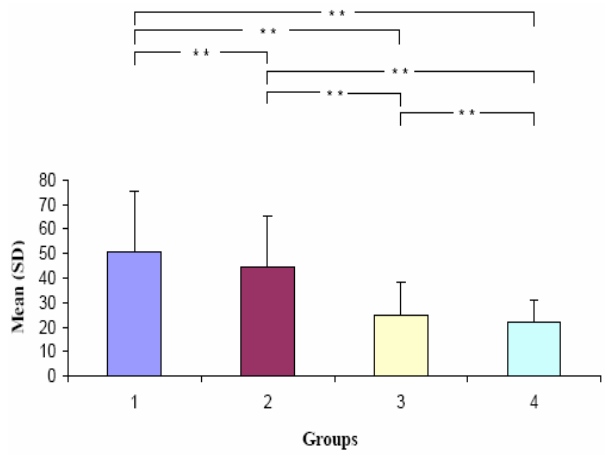
Figure 4 : Comparison between adherence indexes (mean ± DS). *, P<0.05; **, P<0.001. The completeness indicator per group is indicated by Figure 5. The median values range from 196.03 for group 1 to 176.59 for group 2 (group 1 versus group 2 where p <0.05); to 94.42 for group 3 (group 1 versus group 3 where p <0.001; group 2 versus group 3 where p < 0.001); to 90.25 for group 4 (group 1 versus group 4 where p <0.001; group 2 versus group 4 where p <0.001; group 3 versus group 4 where p <0.05).